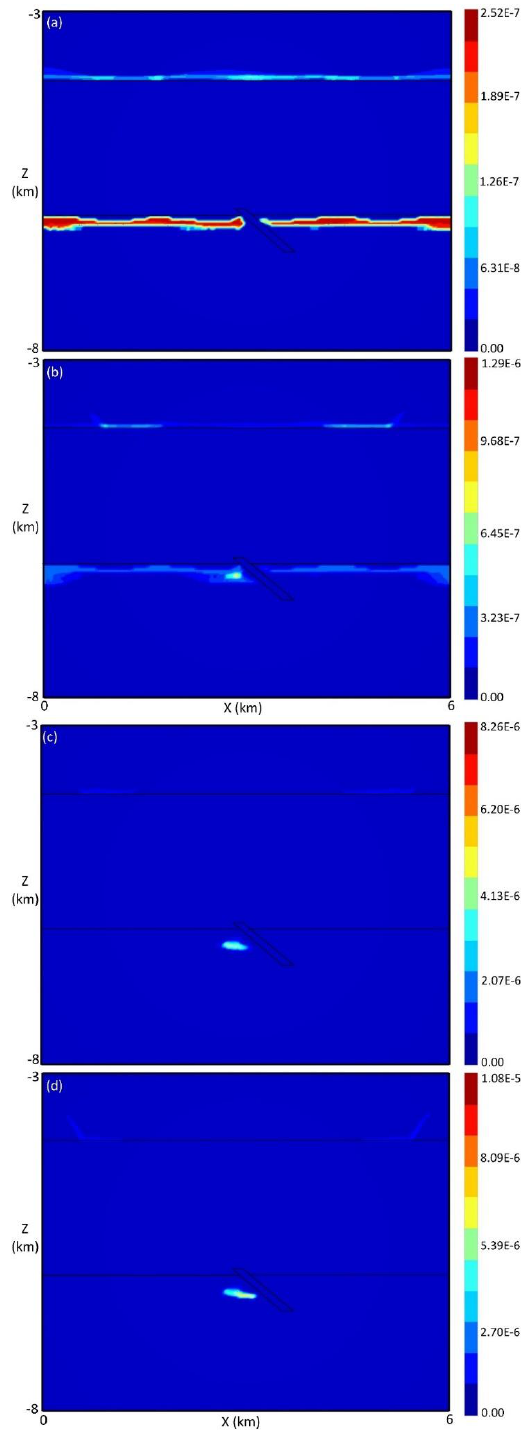
Figure 4. Numerical results of the precipitated uraninite and volume fraction for Scenario 1: ( a ) at 10,000 years, ( b ) at 50,000 years, ( c ) at 150,000 years, and ( d ) at 300,000 years.